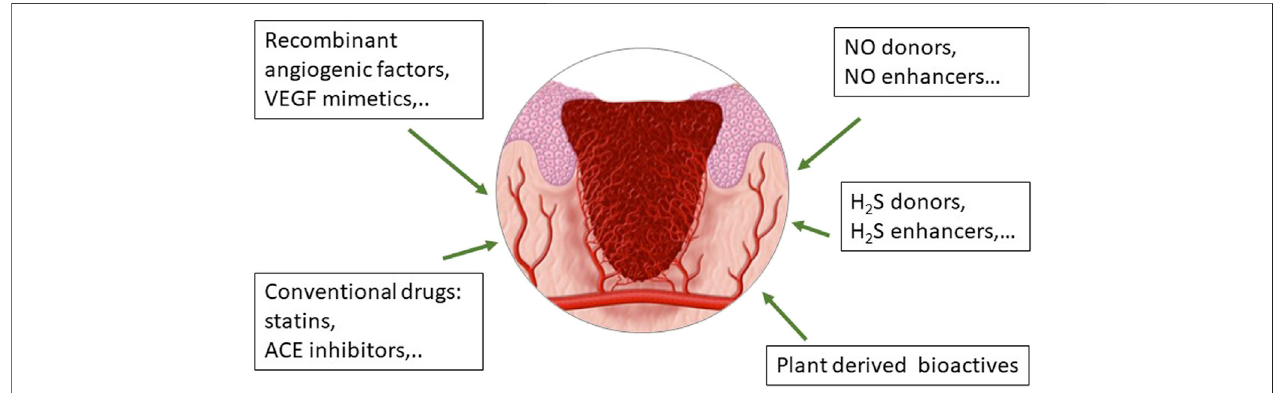
FIGURE3| Drugsinuseorunderdevelopmenttoimprovewoundhealingthroughtheireffectonendothelialfunctioningandangiogenesis,crucialeventsduringthe formation, and evolution of the granulation tissue.